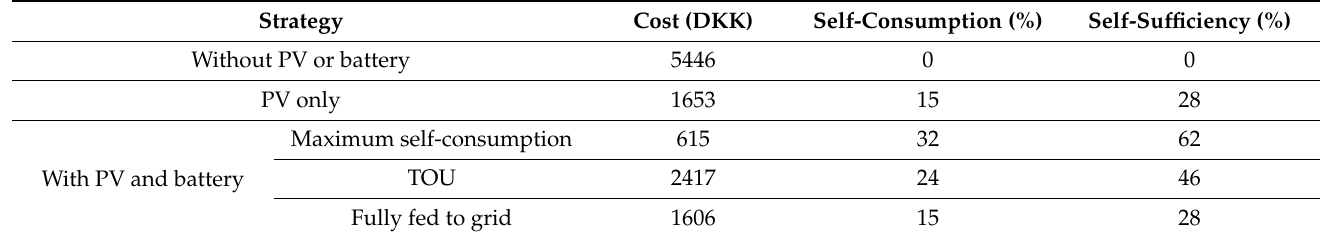
Table 4. Simulation results of different strategies based on spot price in